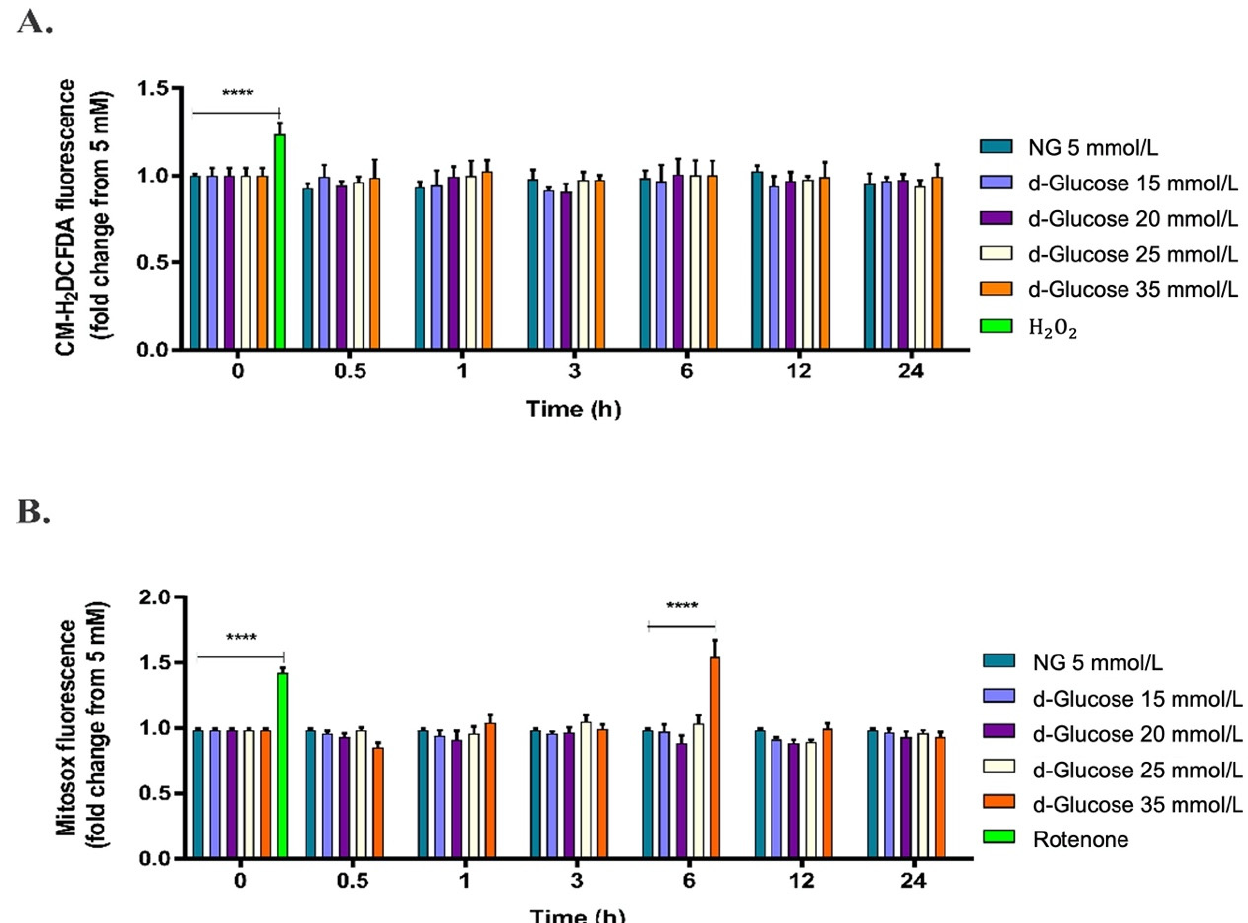
Figure 1. Effect of high d-glucose on cytosolic and mitochondrial ROS production. HAECs were seeded in 96-well plates and exposed to glucose concentrations ranging from 5 mmol/L to 35 mmol/L from 0 to 24 h. ( A ) Cytosolic and ( B ) mitochondrial ROS production was measured by fluorometry with CM-H 2 DCFDA and MitoSOX TM , respectively. Treatments with 100 µ mol/L H 2 O 2 or 10 µ mol/L rotenone were used as positive controls, respectively. Data are presented as change in mean of fluorescence of each probe regarding 5 mmol/L d-glucose conditions ± SEM of at least three independent experiments (**** p < 0.0001).